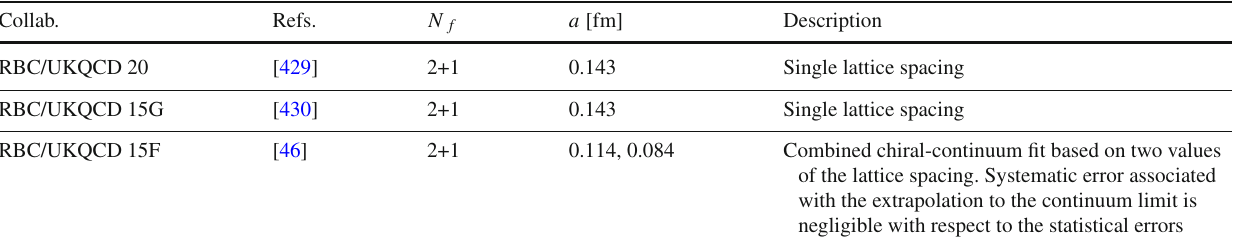
Table 121 Continuum extrapolations/estimation of lattice artifacts in determinations of the K → ππ decay amplitudes Collab. Refs.